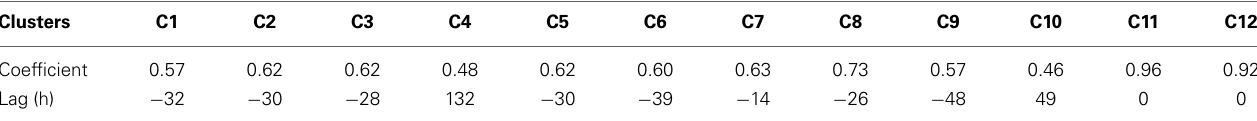
Table 1 | Maximum cross correlation coefficient and associated lag time of wind speed and cluster abundance time series between October 5th 00:00 and October 11th